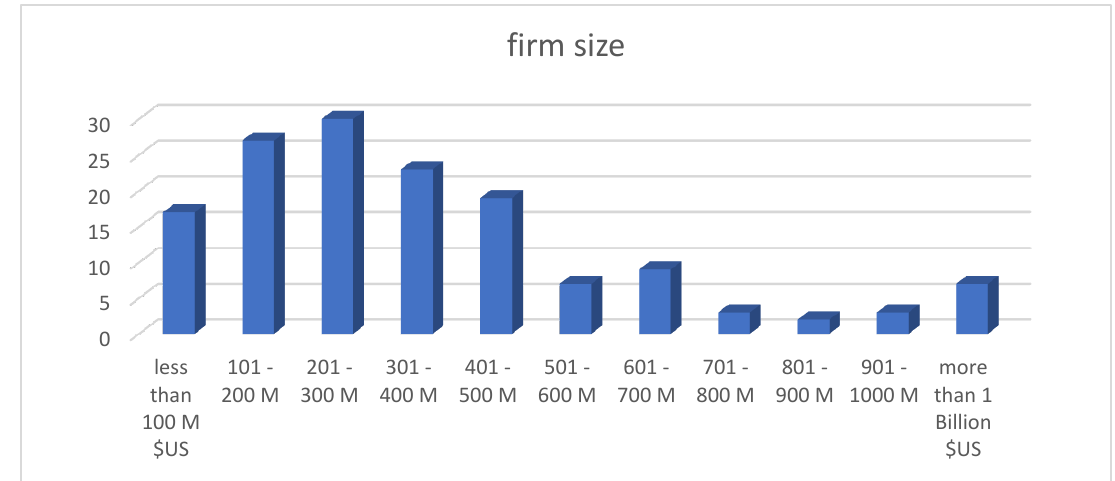
Figure 3. Distribution of Kuwaiti firms based total assets to the nearest 100 M USD.